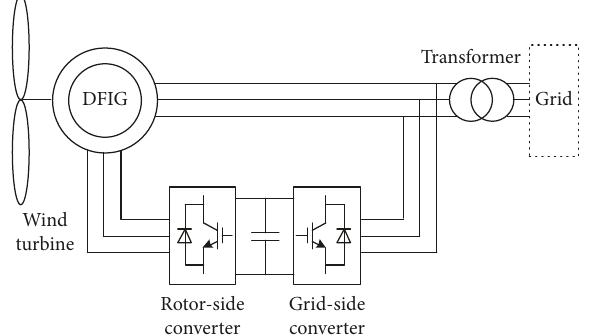
Figure 1: Double-fed wind power generation